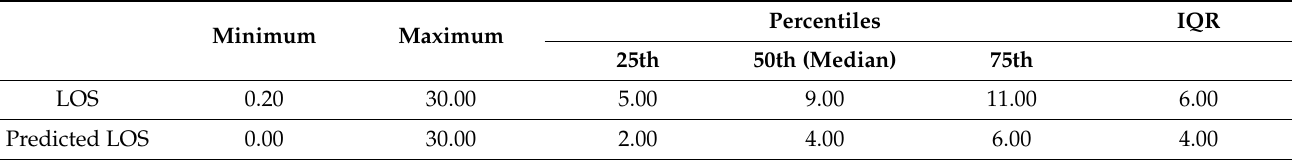
Table 1. Median values for length of stay (LOS) and predicted LOS—descriptive statistics. Percentiles IQR Minimum Maximum 25th 50th (Median) 75th LOS 0.20 30.00 Predicted LOS 0.00